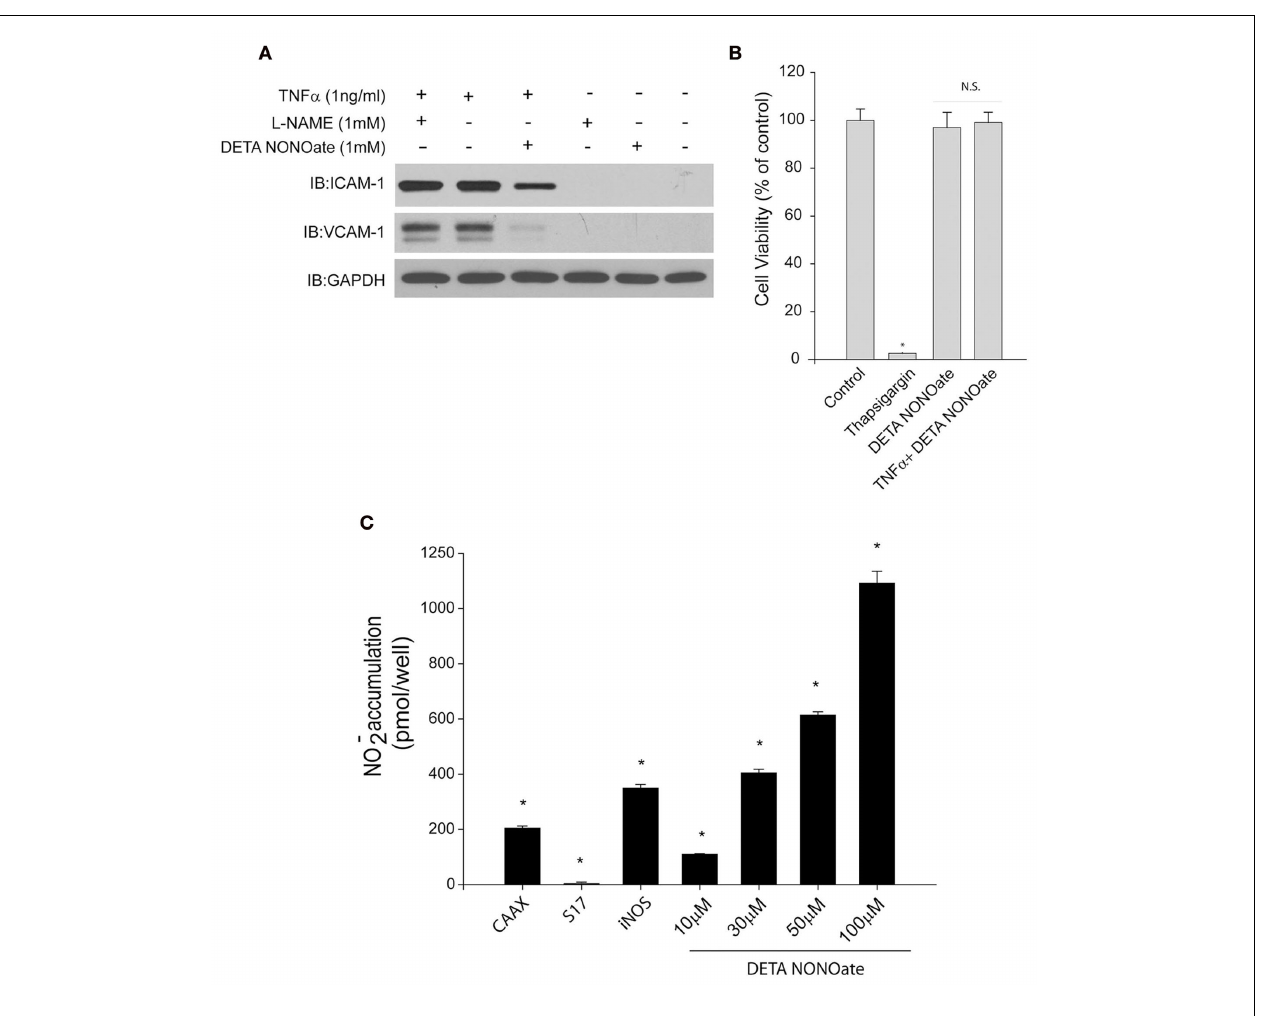
FIGURE 3 | (A) Human aortic endothelial cells were treated with L-NAME (1mM) or DETA NONOate (1mM) for 30min, and thenTNF α (1ng/ml) was added for 24h. Activation of NF- κ B was detected by anti-ICAM-1 or anti-VCAM-1 antibodies. GAPDH was used as a loading control. (B) HAECs were plated into 96-well plate and cells were treated with the same condition